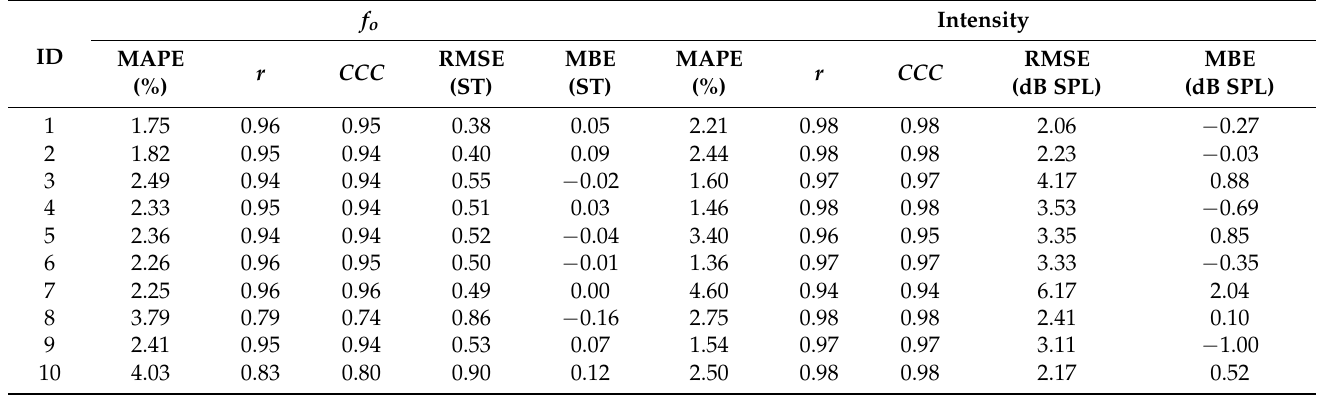
Table 3. Single-speaker f o and intensity model performance on the test set for 10